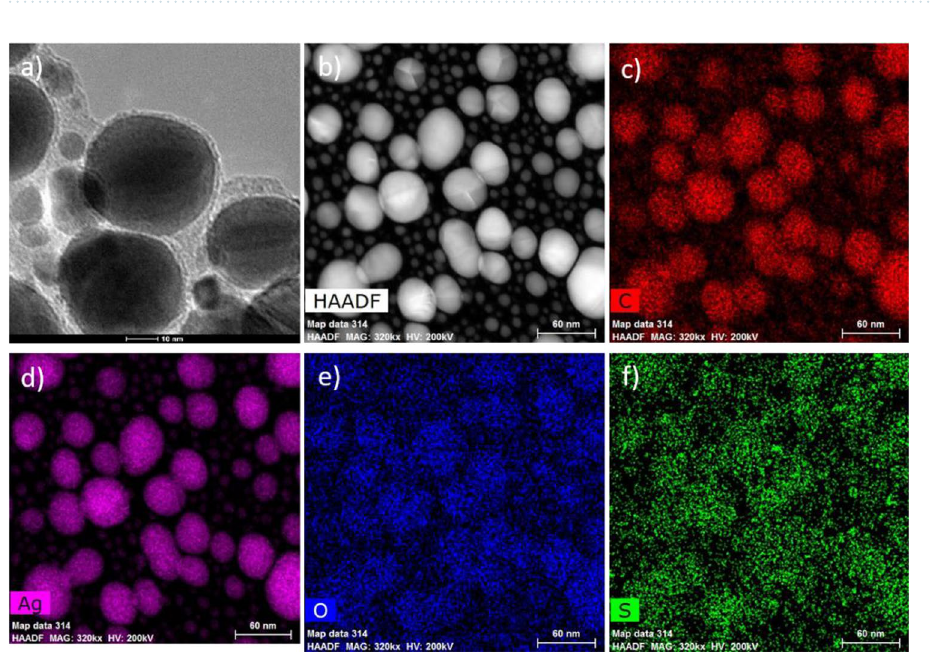
Figure 10. Thermal annealing induced nanoparticles formation. ( a , b ) STEM/TEM micrograph of the Ag nanoparticles at 550 °C on the TEM grid, in addition to elemental maps of ( c ) Carbon on red ( d ) silver on pink ( e ) Oxygen on blue ( f ) Sulfur on green and surrounding matrix. The results show homogenized distributions of S on the nano